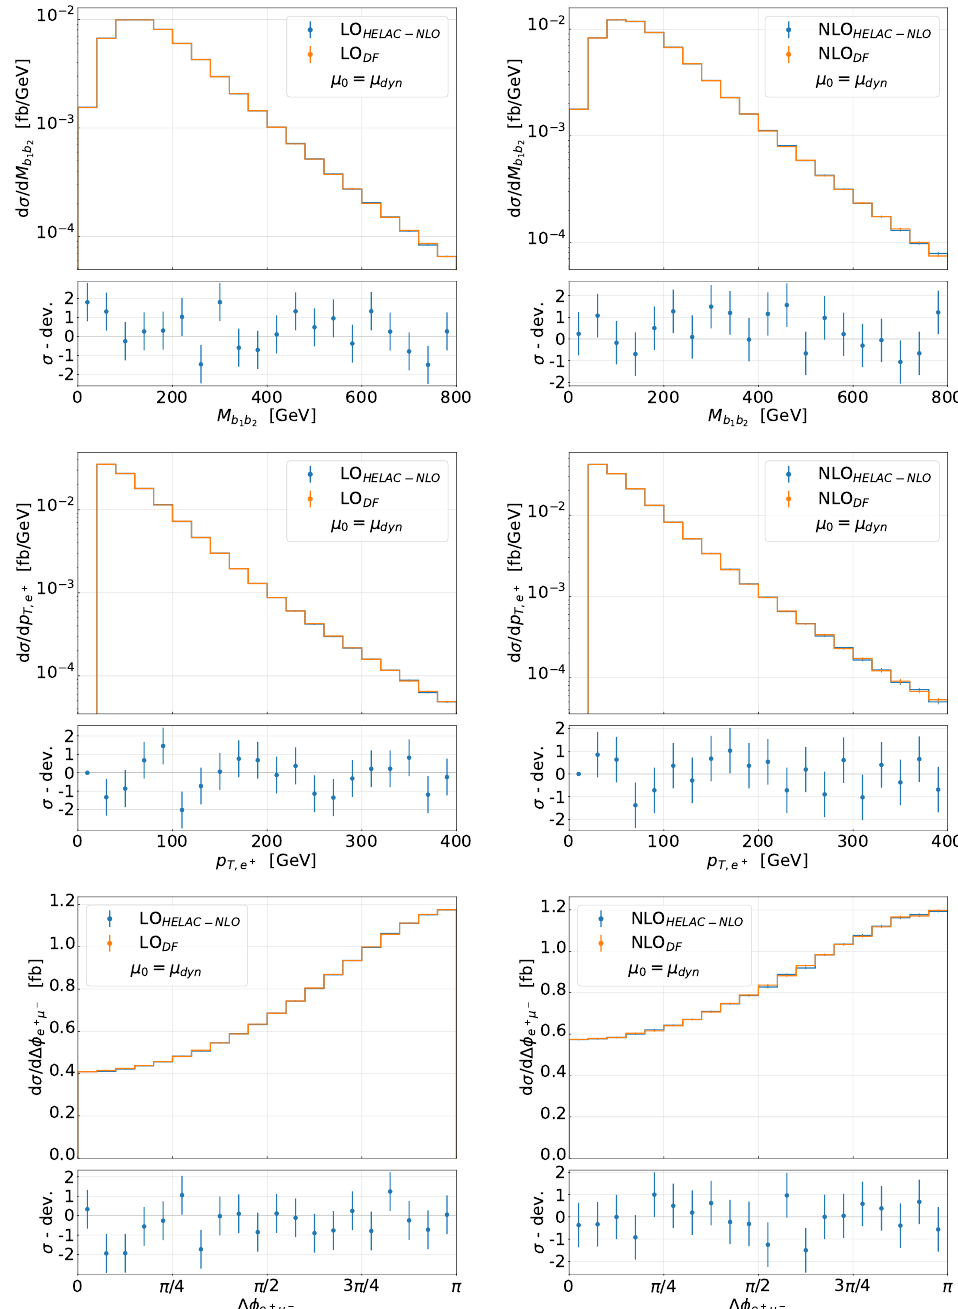
Figure 2 . Differential distributions for the observables M b QCD for the pp → e + ν e µ − ¯ ν µ b ¯ b H process at the LHC with using µ 0 = µ dyn and the CT10NLO PDF set. Also given is a comparison between Helac-Nlo and the results from ref. [33] (indicated by DF). Lower panels display the difference between both calculations in standard deviations (denoted as σ